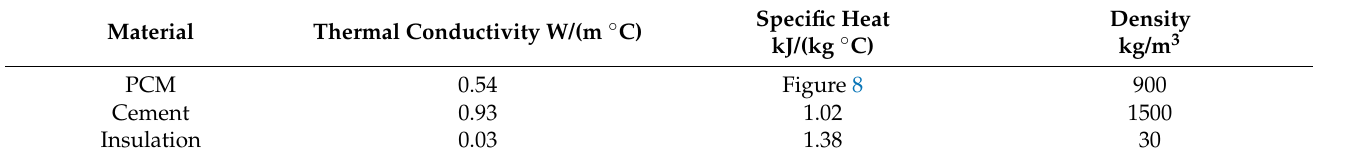
Table 2. Material physical parameters of each layer of the experimental